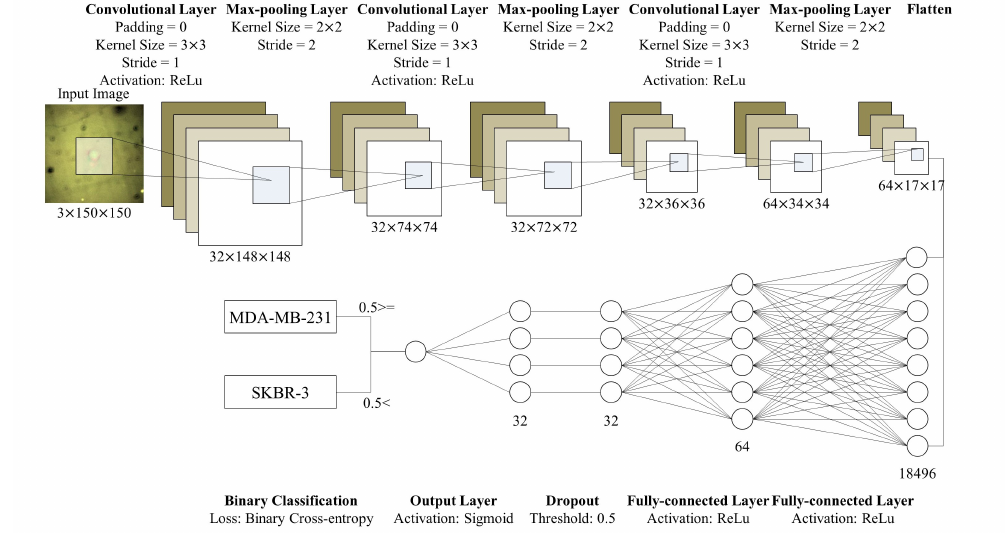
Figure 7. Structure of the proposed CNN model. This model consists of three convolutional layers and two FC layers. After each convolutional layer, we place max-pooling layers. We flatten outputs of the convolutional part and put it into the FC layers. After the first FC layer, we conduct dropout with a threshold, 0.5. Then, the output layer (the second FC layer) prints a single value in [0,1]. Based on the value, we discriminate whether cells in the input images are significantly deformed or